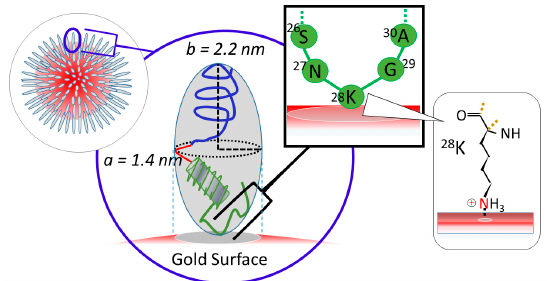
Figure 5. The proposed attachment structure of A β 1–40 over the surface of a gold colloidal particle. At the left top sketch shows the proposed peptide orientation adsorbed over gold nano particle. In the middle the blow up of each peptide with a prolate shape is shown. Inside the prolate, a sketch of A β 1–40 is shown within a prolate of a = 1.4 nm and b = 2.2 nm. On the top, a blow up and hypothesis of sequences responsible for the adsorption on the gold surface are shown and 28 K was speculated to be in a direct contact with gold surface. At the further right, a structure of Lysine (K) is shown and -NH 3 + group is estimated to be a central point for an adsorption.